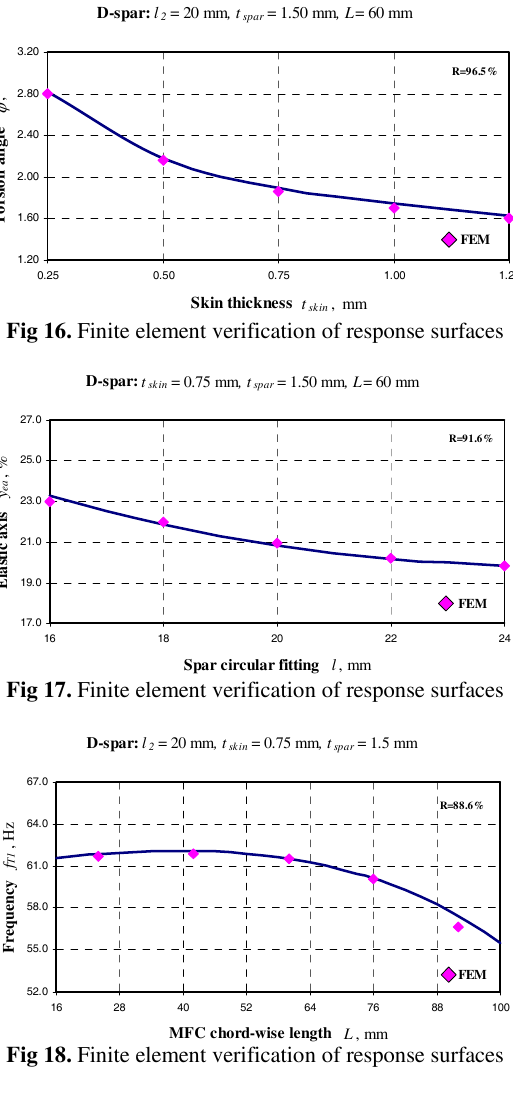
Fig 15. Diagram of elimination for the correlation coefficient Response surfaces for all behaviour functions have been obtained with the correlation coefficients around 90 % and higher. They have been verified by the finite element solutions in the points different from the points taken in the plan of experiments. Results of verification are presented in Figs 16–18.